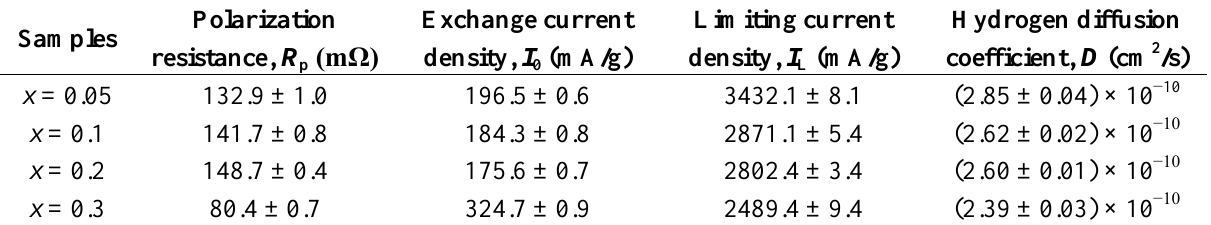
Table 3. Several parameters related to the anode reaction kinetics of Polarization Exchange current Samples resistance, R (mΩ) density, I (mA/g) p 0